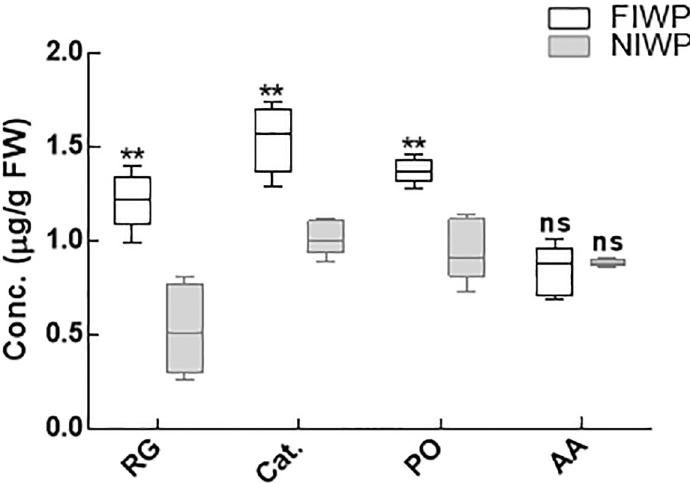
Fig 6. Antioxidant enzyme activities of CGF-1 inoculated and non-inoculated wheat plant. FIWP = fungal inoculated wheat plant; NIWP = non-inoculated wheat plant; RG = reduced glutathione; Cat = catalase; PO = peroxidase; AA = ascorbate. The experiment was carried out in triplicate, each replicate comprised of 10 pots and each pot contained 6 seedlings (total = 6 × 10 × 3 = 180 seedlings per treatment). Means of fungal inoculated wheat plants (FIWP) were compared with non-inoculated wheat plants (NIWP) by using ttest; ‘ �� ’ represents significant difference at P = 0.005; ‘ns’ represents non-significant difference at P = 0.05.